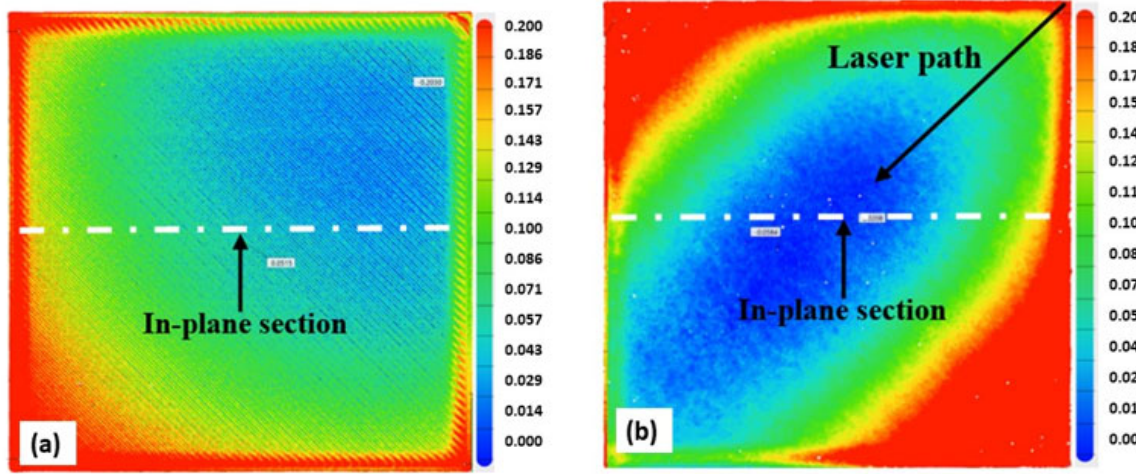
Figure 13. Three-dimensional (3D) topography of the specimen before and after the laser polishing: ( a ) unpolished; ( b ) S3: 50 W laser power, 50 kHz